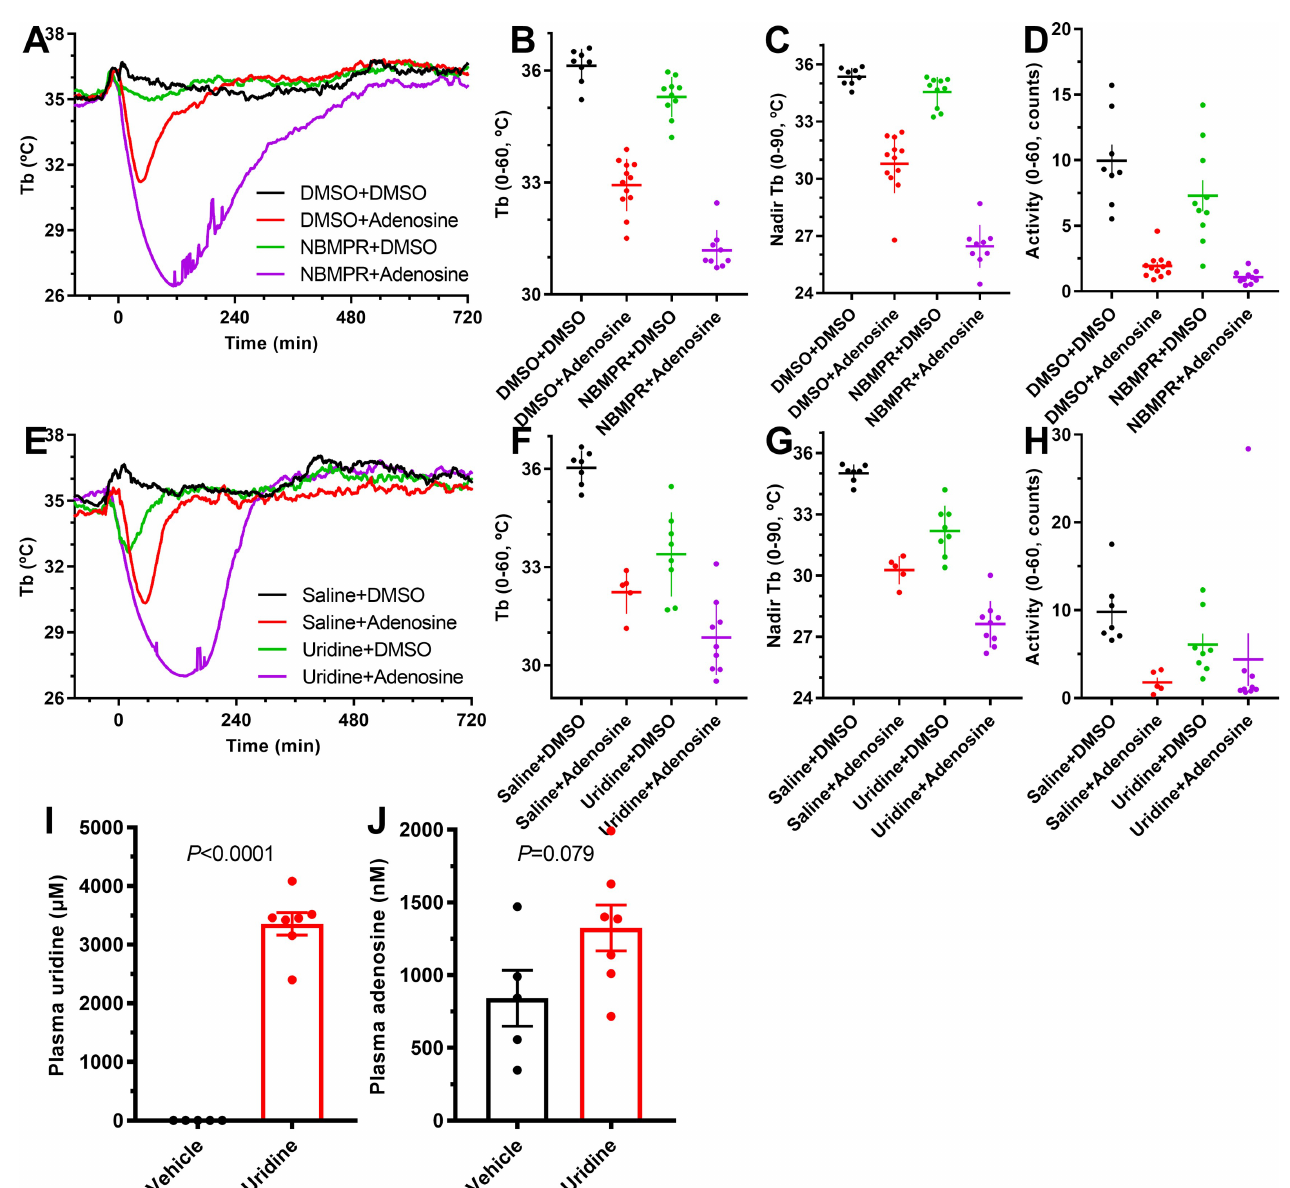
Fig 9. Effect of treatment with ENT1 inhibitor or uridine on hypothermia. (A-D) Effect of the ENT1 inhibitor, NBMPR (1 mg/kg, i.p.), or vehicle on adenosine (100 mg/kg, i.p.) hypothermia in C57BL/6J mice; N = 9–12/group. (E-H) Effect of uridine (1,000 mg/kg, i.p.) or saline on adenosine (100 mg/kg, i.p.) hypothermia in C57BL/6J mice. Adjusted P values ( N = 5–9/group) are in S6 Table. (I-J) Plasma uridine and adenosine levels 30 minutes after uridine (1,000 mg/kg, i.p.) or saline in C57BL/6J mice. P values (unpaired t test; N = 5–7/group) are for effect of uridine versus vehicle. The numerical data are in Supporting information. ENT1, equilibrative nucleoside transporter 1; i.p., intraperitoneal; NBMPR, 6-S-[(4-Nitrophenyl)methyl]-6-thioinosine; Tb, core body temperature.